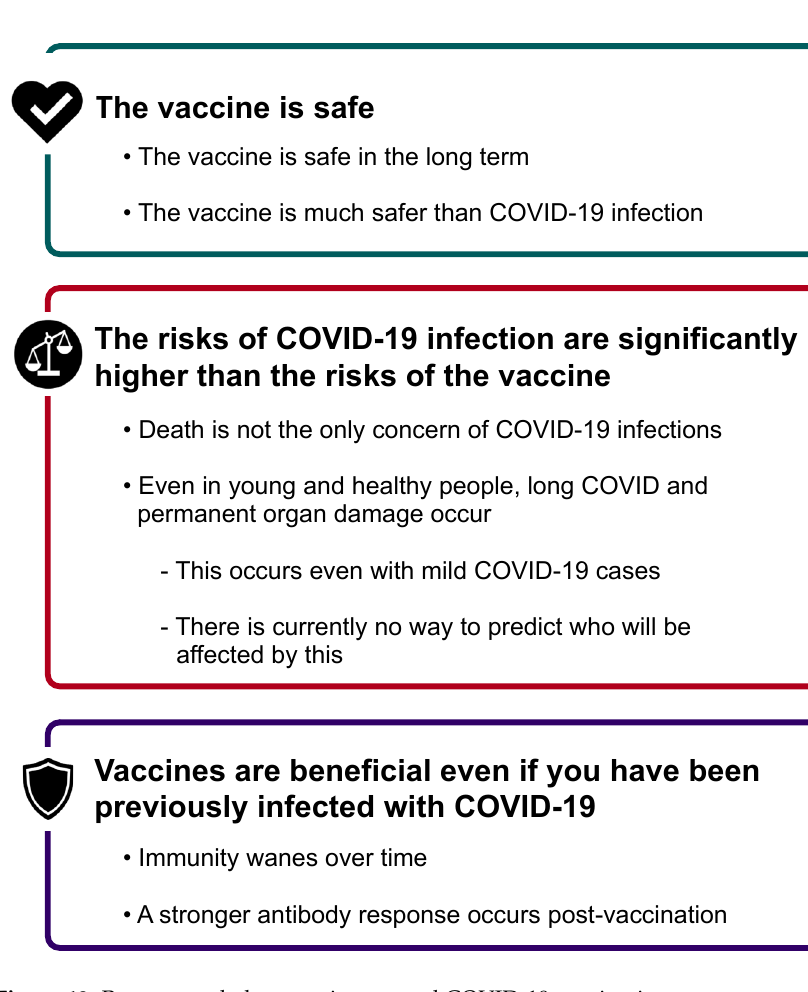
Figure 13. Recommended messaging around COVID-19 vaccination.